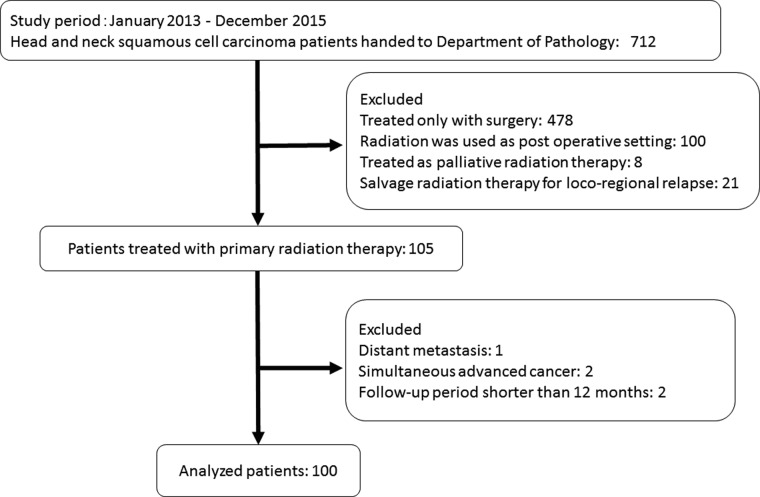
Consolidated Standards of Reporting Trials (CONSORT) flow diagram of consecutive HNSCC patients whose biopsy specimens were handed to our Department of Pathology from January 2013 to December 2015.